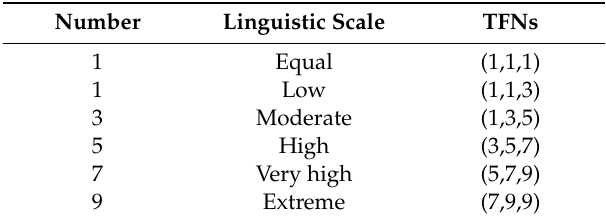
Table 6. Linguistic variables for the importance weight of each